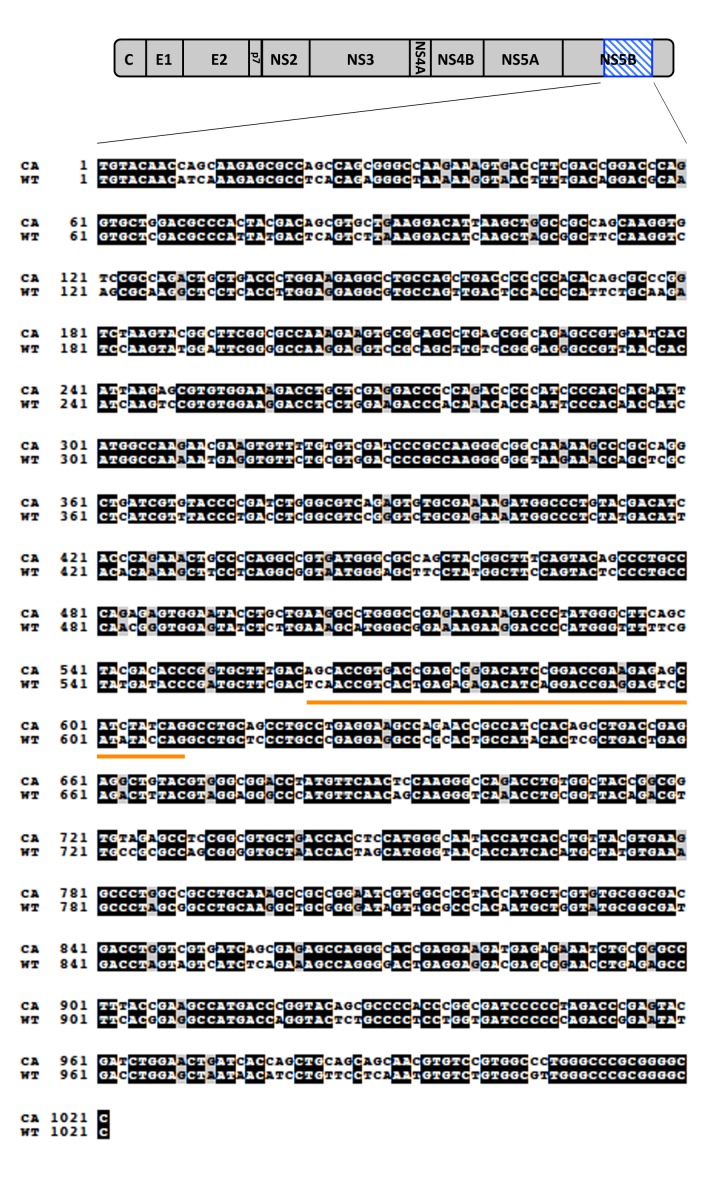
Alignment of codon-altered and wild-type JFH1 viral RNAs.Sequence alignments were generated using ClustalW to highlight the nucleotide changes incorporated into the CA-2 viral RNA. Sequences highlighted with orange bars identify regions containing covarying mutations indicating functional RNA secondary structures.